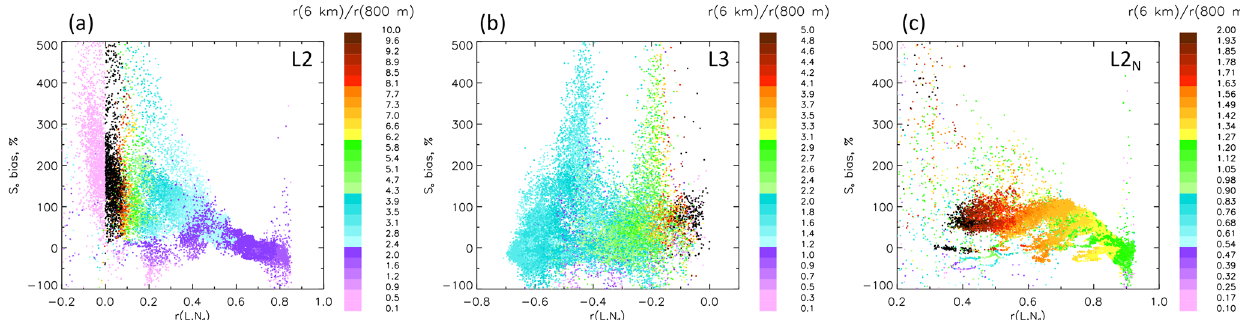
Figure 5. As in Fig. 4 but with points colored by the ratio of σ A of the S o bias on the σ ratio and that the bias ∼ 0 when the σ ratio ∼ 1 (green colors). Exceptions to the latter occur for L2 at low r ( L , N d ).